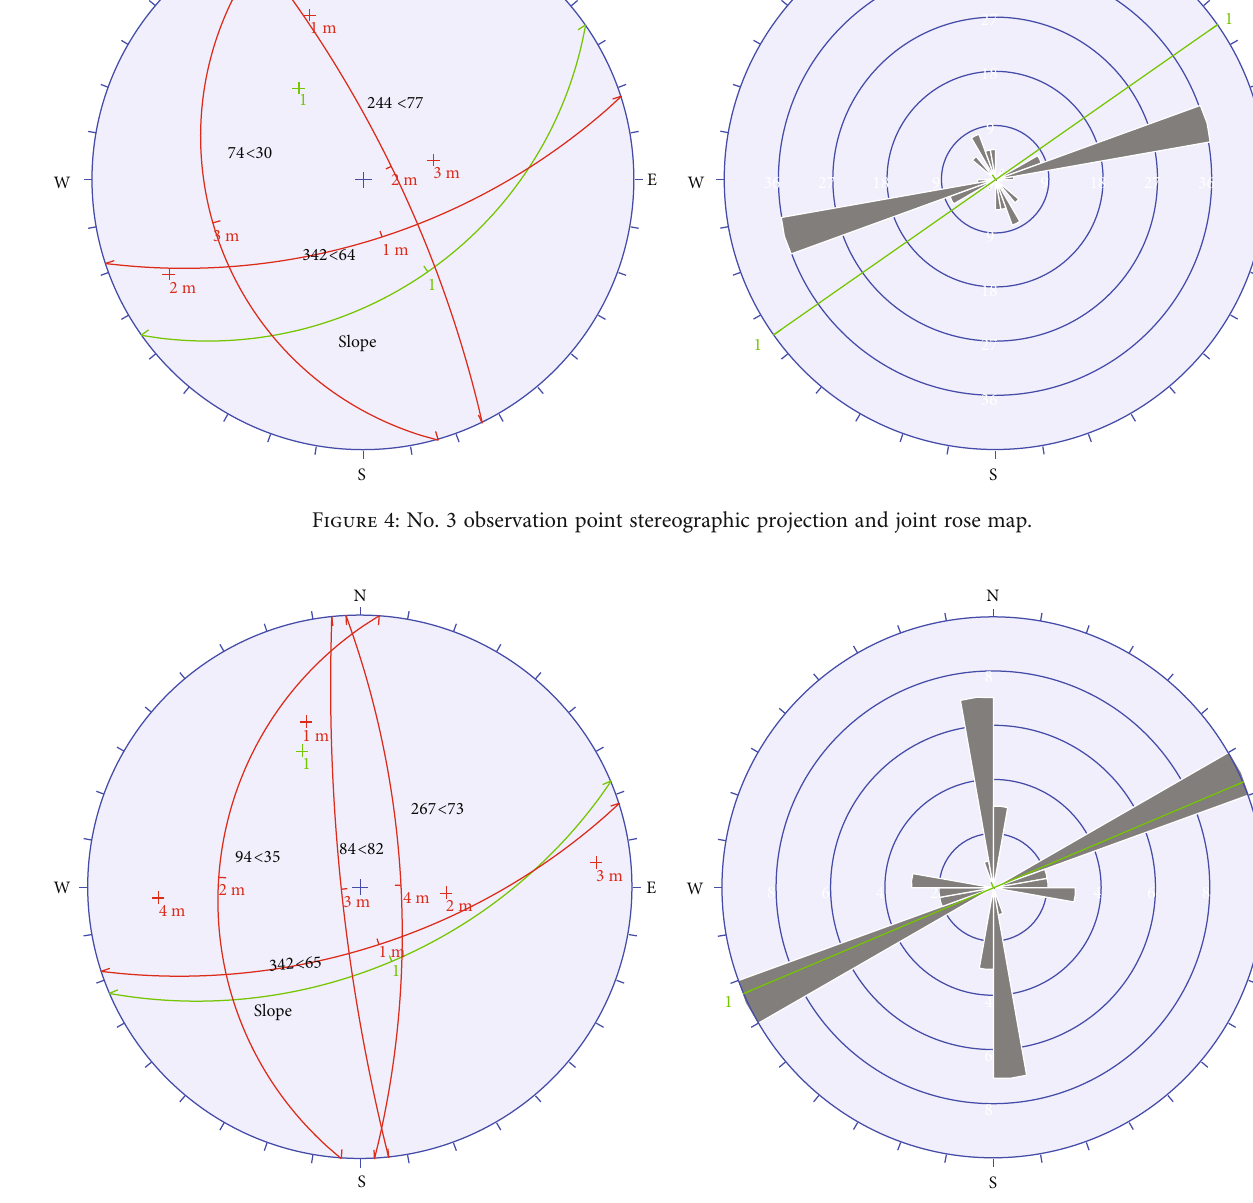
Figure 5: No. 4 observation point stereographic projection and joint rose